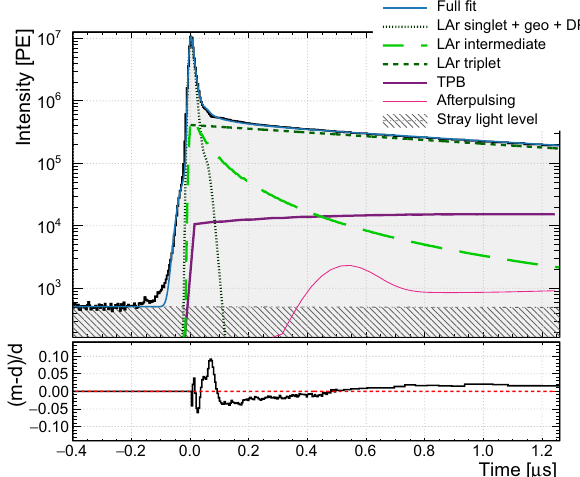
Fig. 7 The prompt region of the pulseshape, including the so-called intermediate times (approx. 40 ns to 100 ns), is well described by our LAr scintillation model. The time region before − 8 ns is not part of the fit the value of χ 2 from the nominal fit. While in this case, the reduced χ 2 parameter cannot be used to infer a p-value, the relative difference for different model parameters is still a useful quantity saying something about how close the model comes to the data. The box in the very center, outlined with a dashed line, is the nominal fit. Figure 9 shows the fit with nominal parameters, but the shape of the LAr intermediate component is changed to a simple exponential decay. The ratio of χ 2 between this